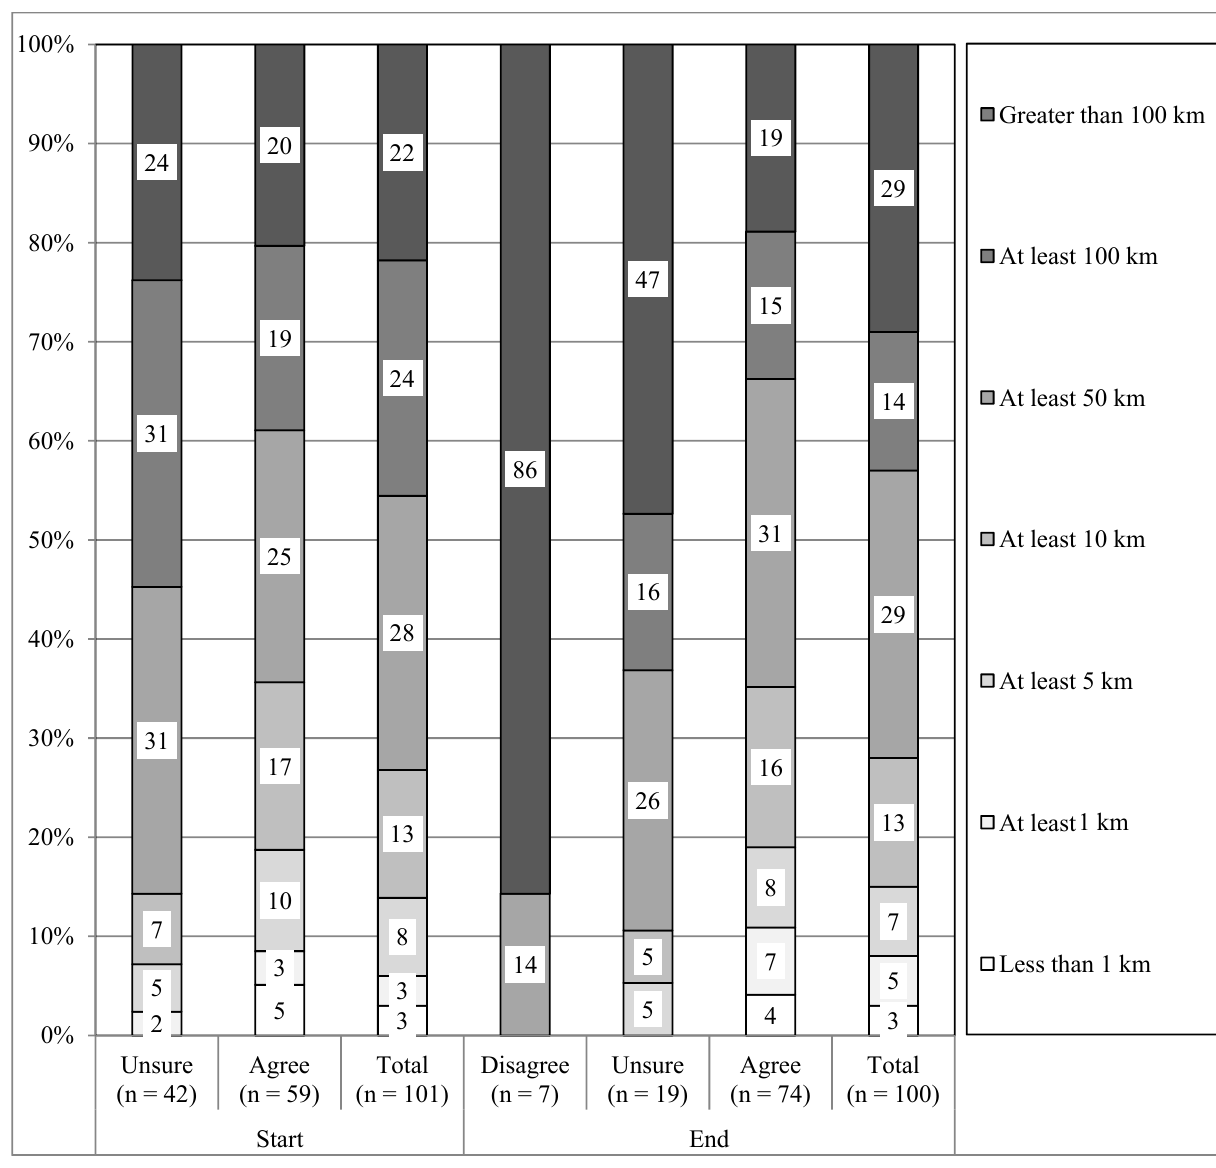
Figure 4. Percentage of agreement with distance of geothermal projects from built-up areas in the